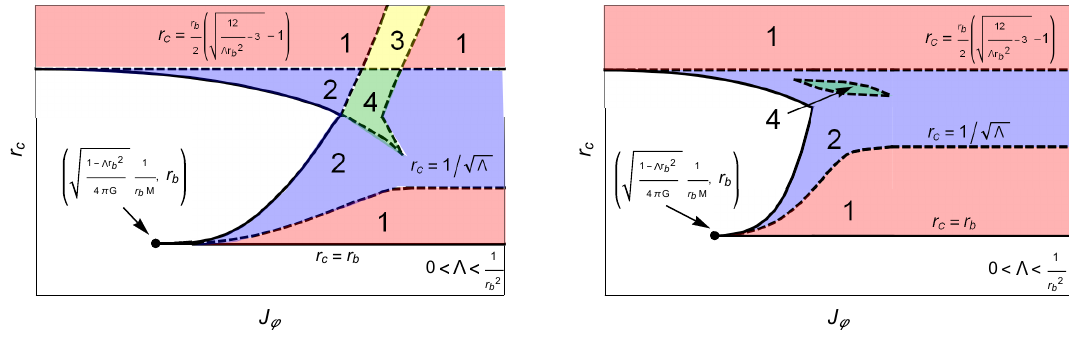
Figure 13 . Other examples of qualitative behavior of range of possible size of cosmological horizon . The numbers in the figures represent the number r c of BG instanton against J ϕ when 0 < Λ ≤ 1 r 2 b of solutions with the same r and J . (Examples of parameters that exhibit these structures are c ϕ √ √ √ √ ( r Λ , M ) = (7 G, 0 . 002 /G, 0 . 1 / G ) ( Left ) and ( r b , Λ , M ) = (3 G, 0 . 0056 /G, 0 . 1 / G ) ( Right b ,